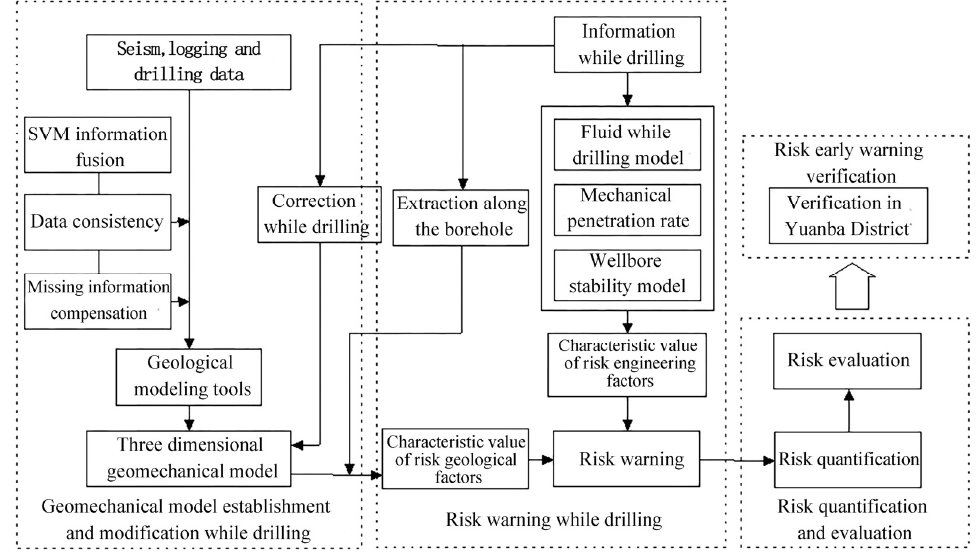
Figure 1. Design idea of risk assessment and prediction while drilling.